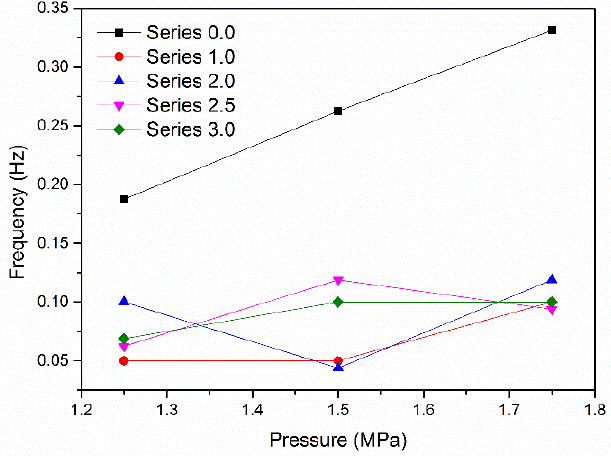
Figure 17. Dominant frequency in the frequency modulation.